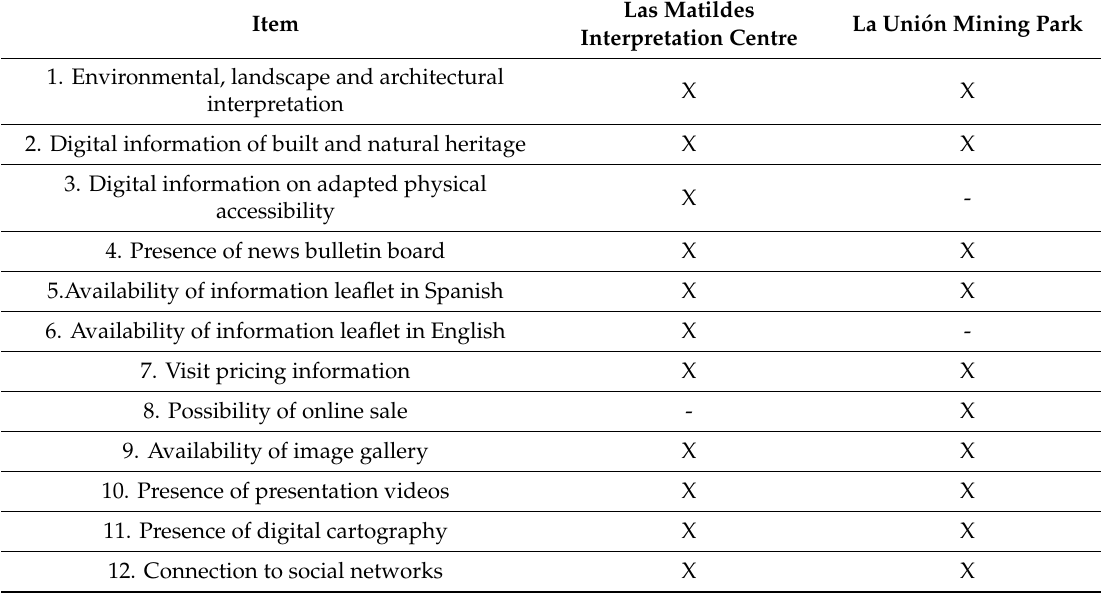
Table 4. Main items of landscape and information digitalization.